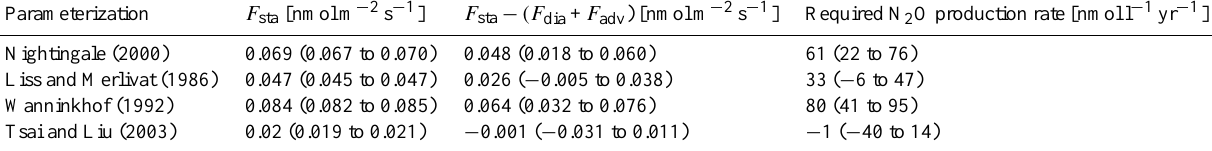
Table 1. Sea-to-air fluxes ( F sta ) of N 2 O calculated with different gas exchange parameterizations and corresponding N 2 O production rates at a ML depth of 25m required to compensate the discrepancy between the sea-to-air flux and the sum of diapycnal ( F dia ) and vertical advective ( F adv ) flux.